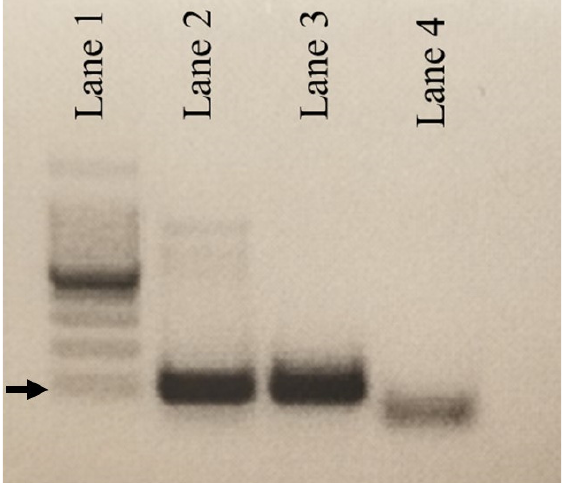
Figure 1. Gel electrophoresis products from cPCR in DNA isolated from a U.S. cat. DCH is identified by PCR from one cat from Ventura County, California. Lane 1 = 1 KB ladder; Lane 2 = PCR product from DNA extracted from the blood of a shelter cat from Ventura County, CA; Lane 3 = positive control provided from UC Davis; Lane 4 = Negative control (SPF cat DNA). Primers used are HgapF and HgapR with an expected size range of 200 BP. Arrow indicates approximately 200 bp.